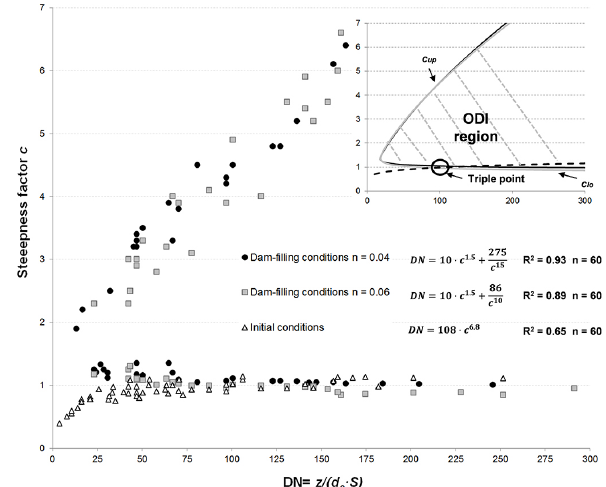
Fig. 8. Relationships between the steepness factor c and the design number DN defining the limits of the optimal dissipation interval (ODI). The fitted curves are depicted on the top-right corner and their equations are shown inside the main plot. c lo represents the lower threshold of ODI; c up the upper threshold of ODI; d c the critical depth; n the Manning roughness coefficient; S the bed slope; and z the effective check dam